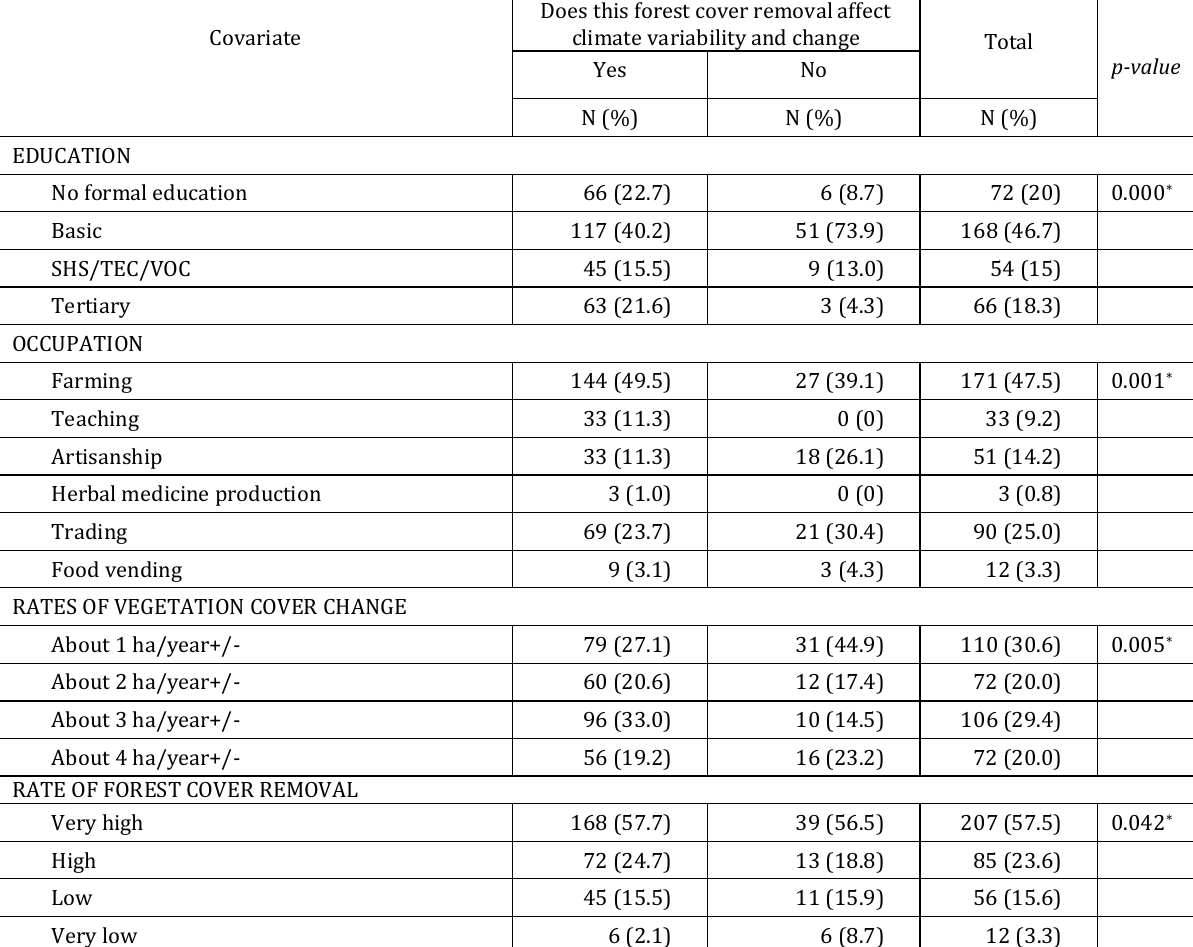
Table 6. Perceived forest cover removal effect on CVC by demographic characteristics and deforestation and forest degradation rate Does this forest cover removal affect Covariate climate variability and